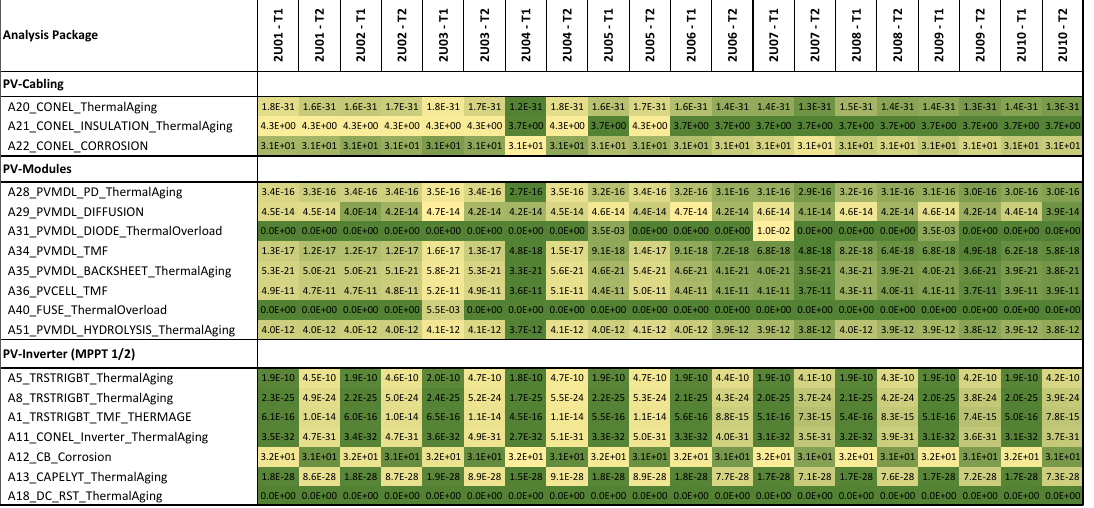
Figure A2. Damage calculation results for MPPTs “2U01 - T1”–“ 2U10- T2” .